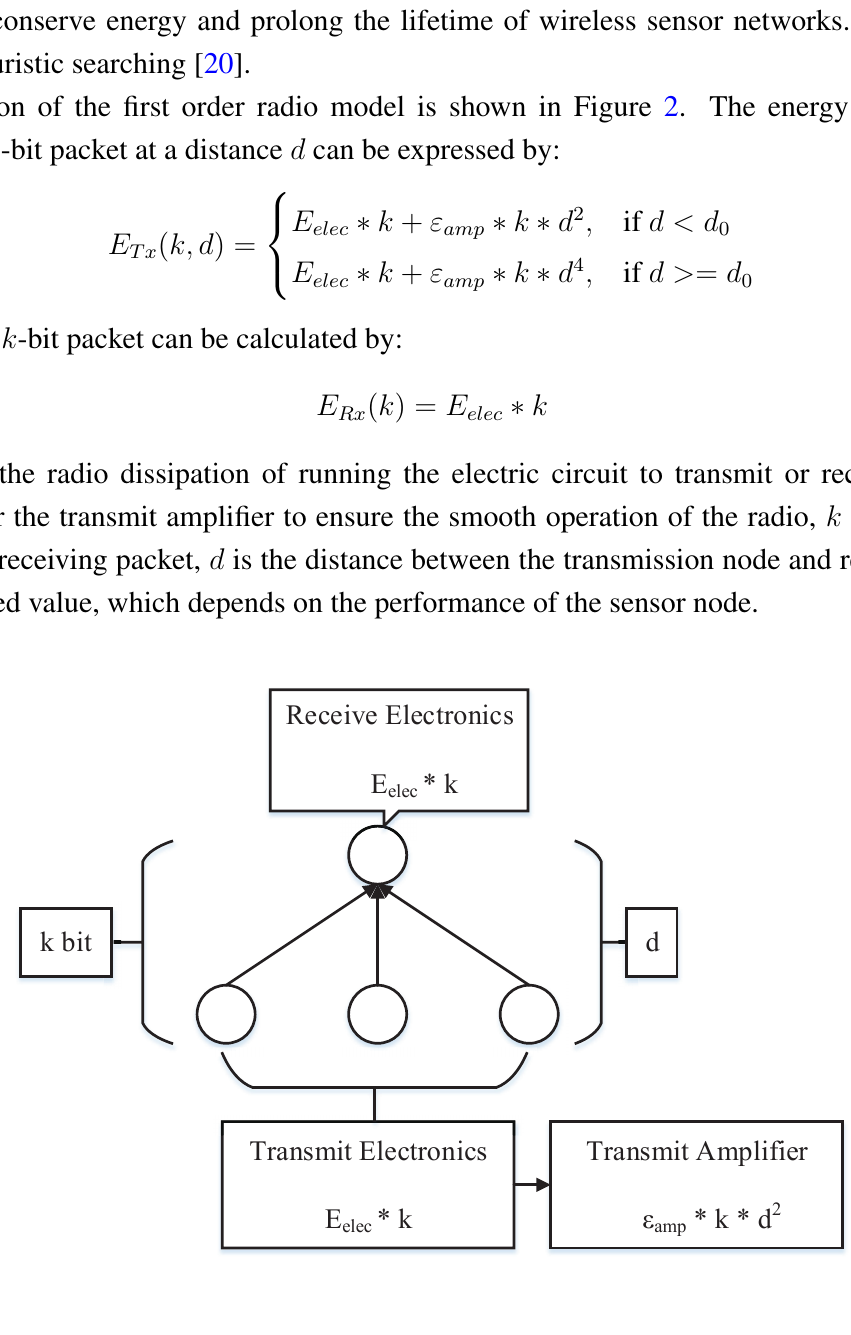
Figure 2. The first order radio